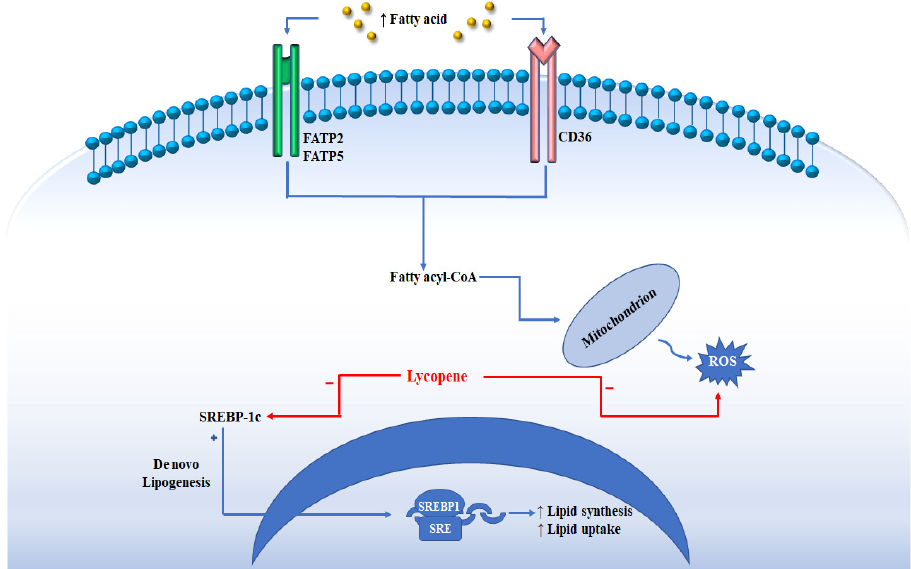
Figure 2. The figure shows how the uptake of circulating fatty acids is facilitated by the transporters present on the membrane FATP2/FATP5 (fatty acid transport protein 2 or 5), and CD36 (cluster of differentiation 36). Once inside the cell, the fatty acids can undergo the beta oxidation process with their transport to the mitochondrion. During NAFLD, the excess of fatty acids determines an increase in the production of ROS. The de novo lipogenesis regulated by SREBP-1c contributes to the accumulation of fat in the liver. The figure indicates how lycopene interacts by reducing the levels of SREBP-1c and